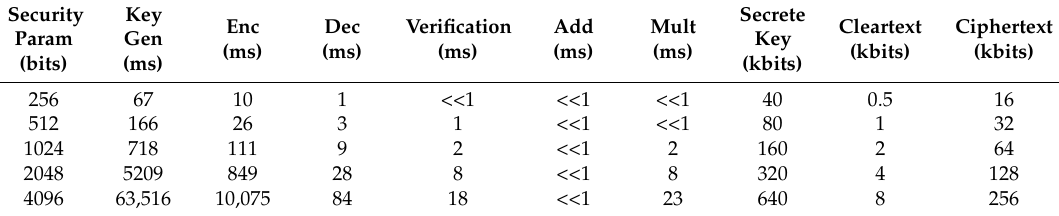
Table 2. Implementation result of our verifiable fully homomorphic encryption